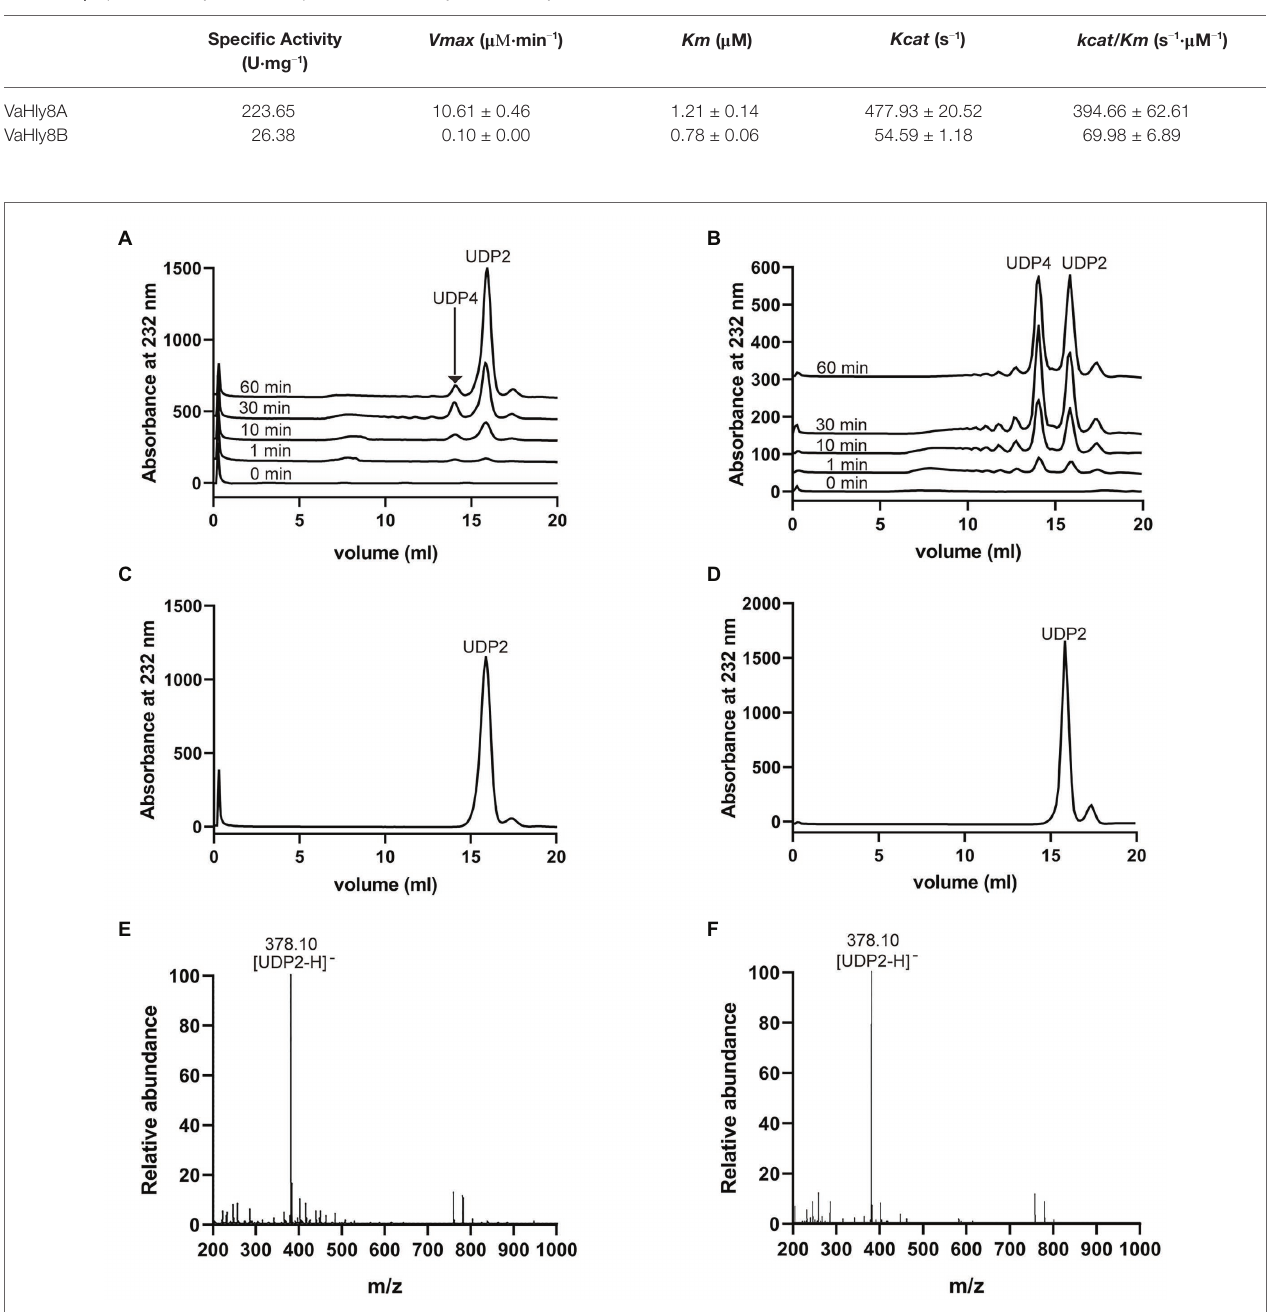
FIGURE 7 | Action modes and final products of VaHly8A and VaHly8B. (A) Time-course treatment of HA using VaHly8A at 30 ° C. (B) Time-course treatment of HA using VaHly8B at 50 ° C. Analysis of the final products of HA digested by VaHly8A (C) and VaHly8B (D) using gel filtration chromatography with a Superdex ™ peptide 10/300 gel filtration column. Electrospray ionization-mass spectroscopy (ESI-MS) analysis of the final products of HA digested by VaHly8A (E) and VaHly8B (F) .